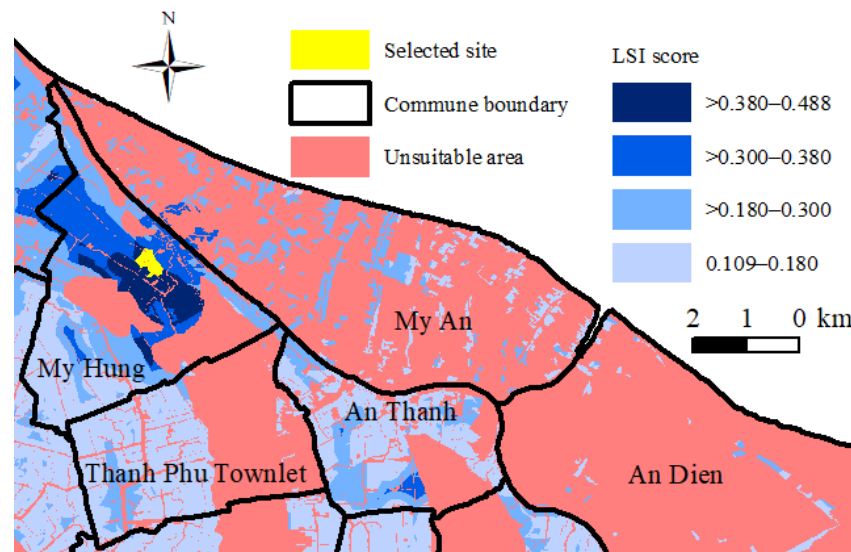
Figure 5. LSI score categories and selected site.